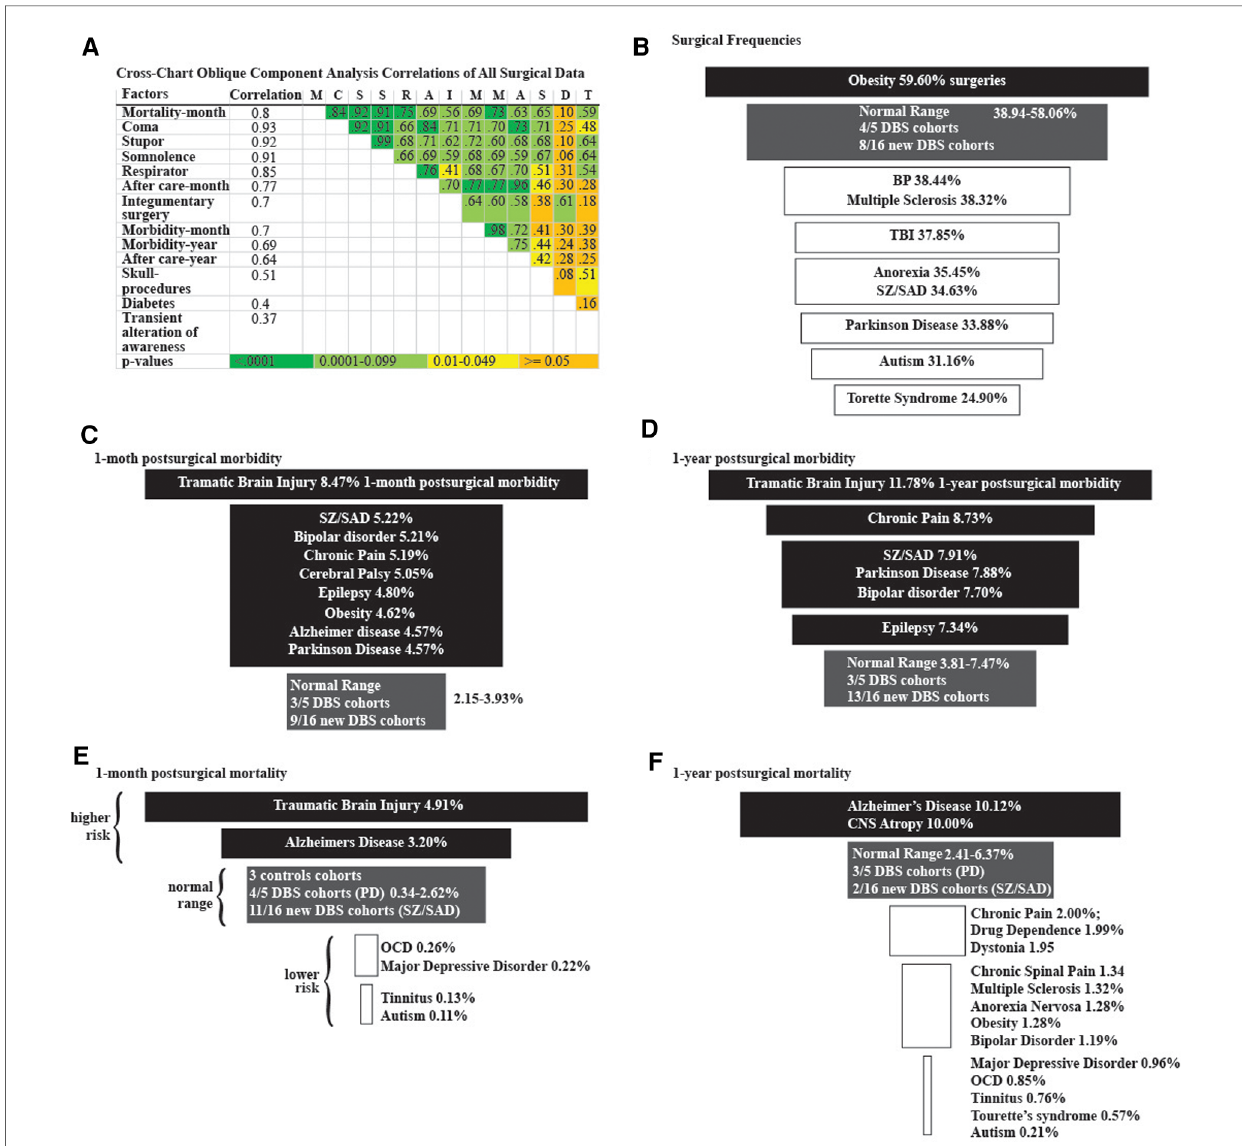
FIGURE 3 Logistic regression analyses. ( A ) Cross-chart showing the group of 13 highly correlated surgical factors identi fi ed from 34,688,986 surgical cases using oblique component analysis. Correlation column is each factor ’ s correlation to the group. Correlations between factors and color-coded p -values are listed in the cross-chart. Funnel plots of ( B ) surgical frequencies, (C ) 1-month postsurgical morbidity, ( D ) 1-year postsurgical morbidity, ( E ) 1-month postsurgical mortality, and ( F ) 1-year postsurgical mortality among diagnostic cohorts. Higher frequencies (black), Normal-range frequencies de fi ned by the results from the three control groups (grey), and lower frequencies